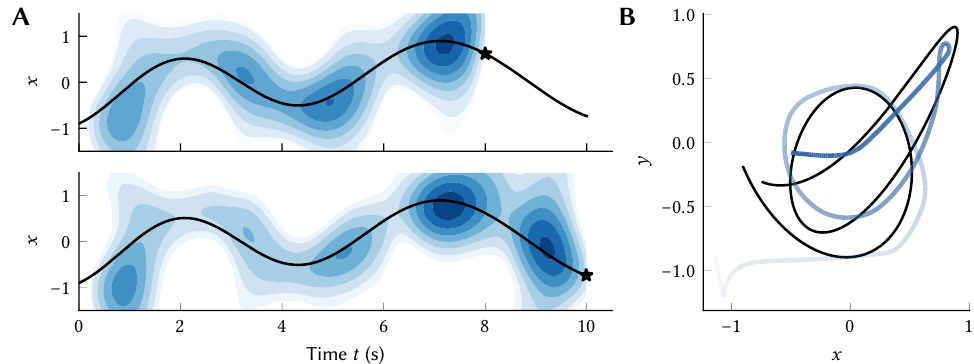
Figure 13. Results from temporal integration of SSPs to obtain trajectory representations. Path integration was performed on a 2D path (the black line in ( B )). The output of the path integrator was fed into a temporal integrator, with dynamics given by Equation (10). ( A ) Two panels show the x -dimension of the trajectory output at different points (indicated by black stars) over the simulation time (the x axis). The output Φ ( t ) is visualized by a contour plot of its similarity with SSP representations across x -space. This is analogous to a probability distribution of the x position at different points in the past (see Section 6). ( B ) The 2D trajectory estimate, decoded from Φ ( t ) at the end of the simulation, as a blue line that fades with how far the estimate is into the